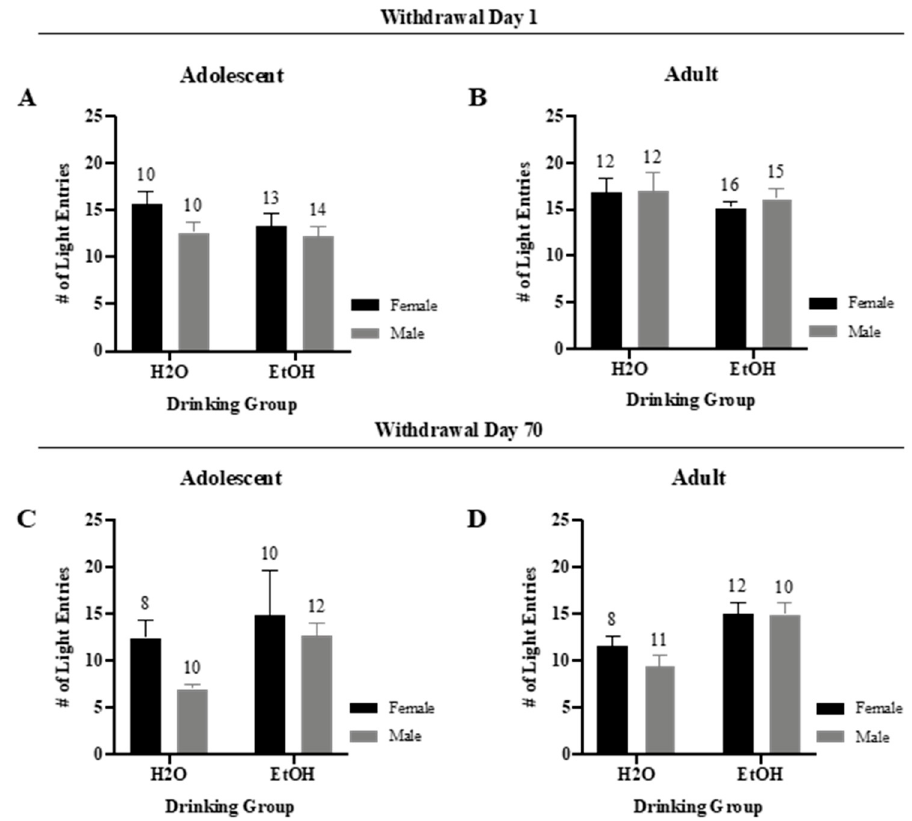
Figure 5. Summary of the results for the Sex × Drinking ANOVA observed for the total number of entries to the light-side in the light–dark shuttle-box test. ( A ) Depiction of the results for the adolescent-onset mice at 1-day withdrawal. ( B ) Depiction of the results observed for the adult-onset mice at 1-day withdrawal. ( C ) Depiction of the results for the adolescent-onset mice at 70-days withdrawal. ( D ) Depiction of the results for the adult-onset mice at 70-days withdrawal. The data represent the means ± SEMs for the numbers of mice indicated in each panel.